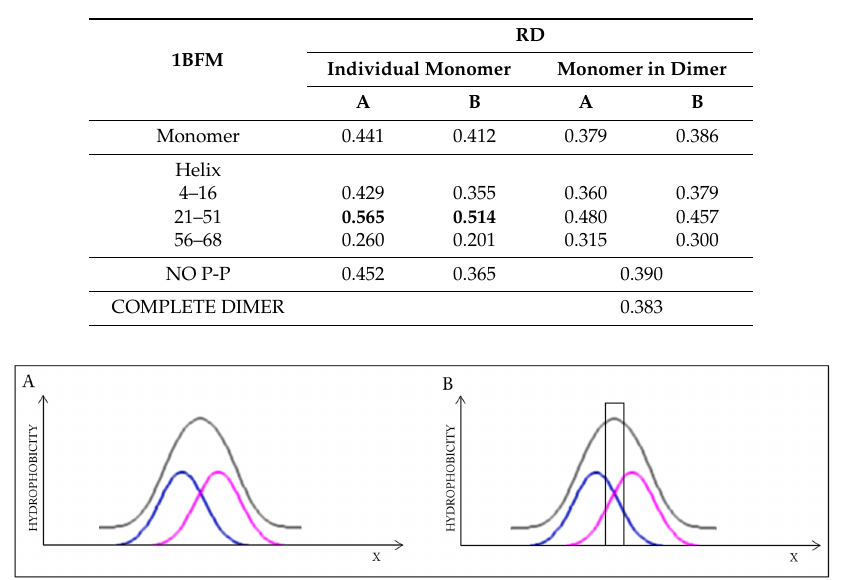
Table 2. RD coefficients describing the status of the hydrophobic core in the dimer and in each monomer of 1BFM. The table also lists the status (with respect to the monomer and the dimer) of individual helical folds. “No P-P” indicates parts of the monomers and the dimer following elimination of residues which make up the P-P interface.